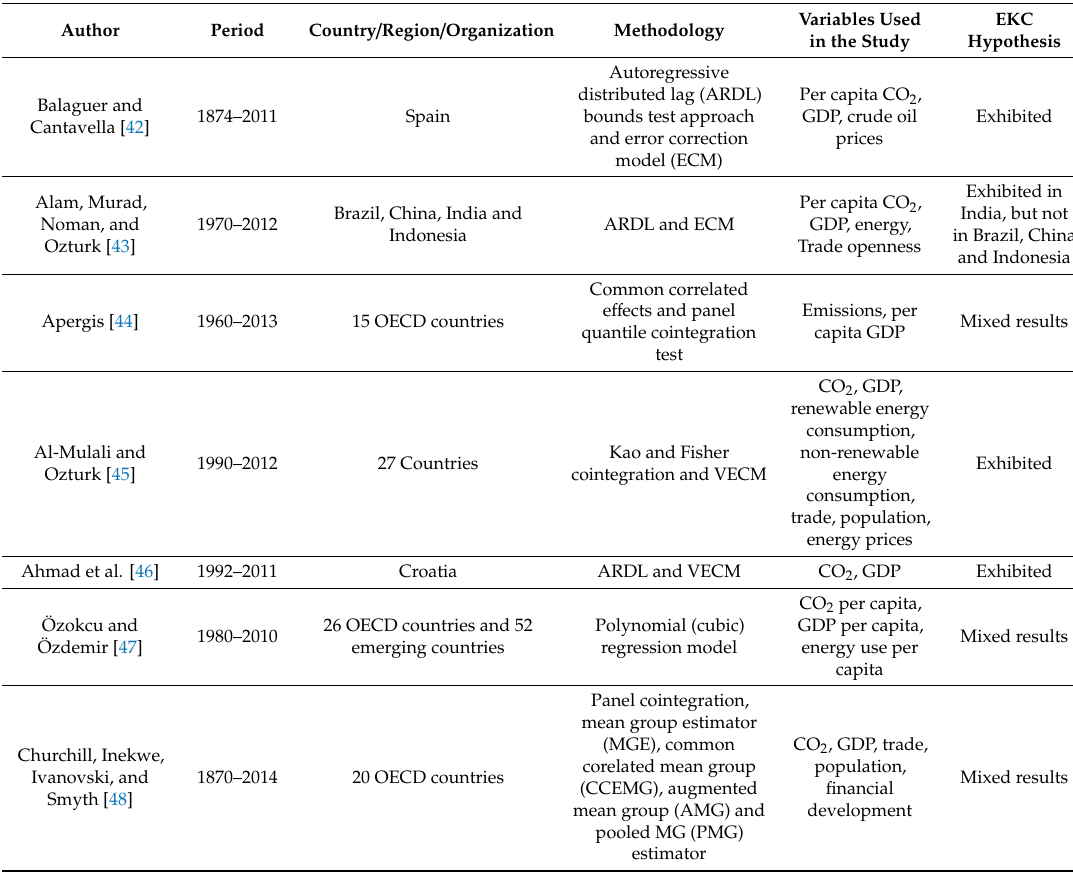
Table 2. Recent studies on environmental Kuznets